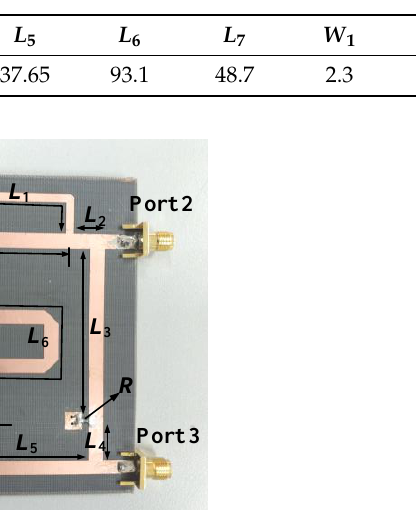
Table 1. Dimensions of the prototype I (unit: mm; referring to Figure 5).